Question: What does this figure show? Answer in one sentence.
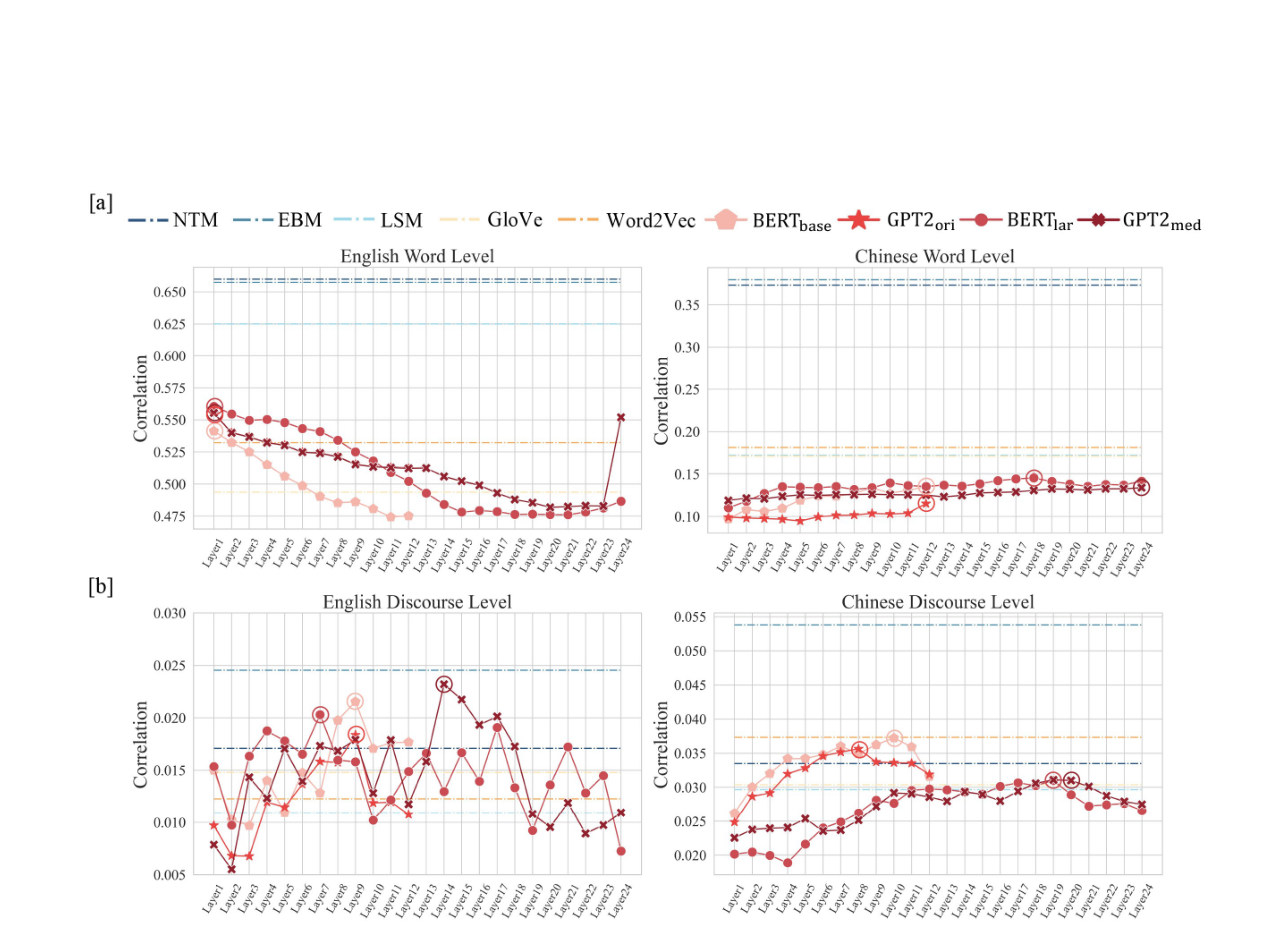
Answer: Mean Pearson correlation coefficients were calculated for each layer of context-aware models in English and Chinese word-level and discourse-level fMRI data across the entire brain. A circle marks the layer with the best encoding performance for each model.